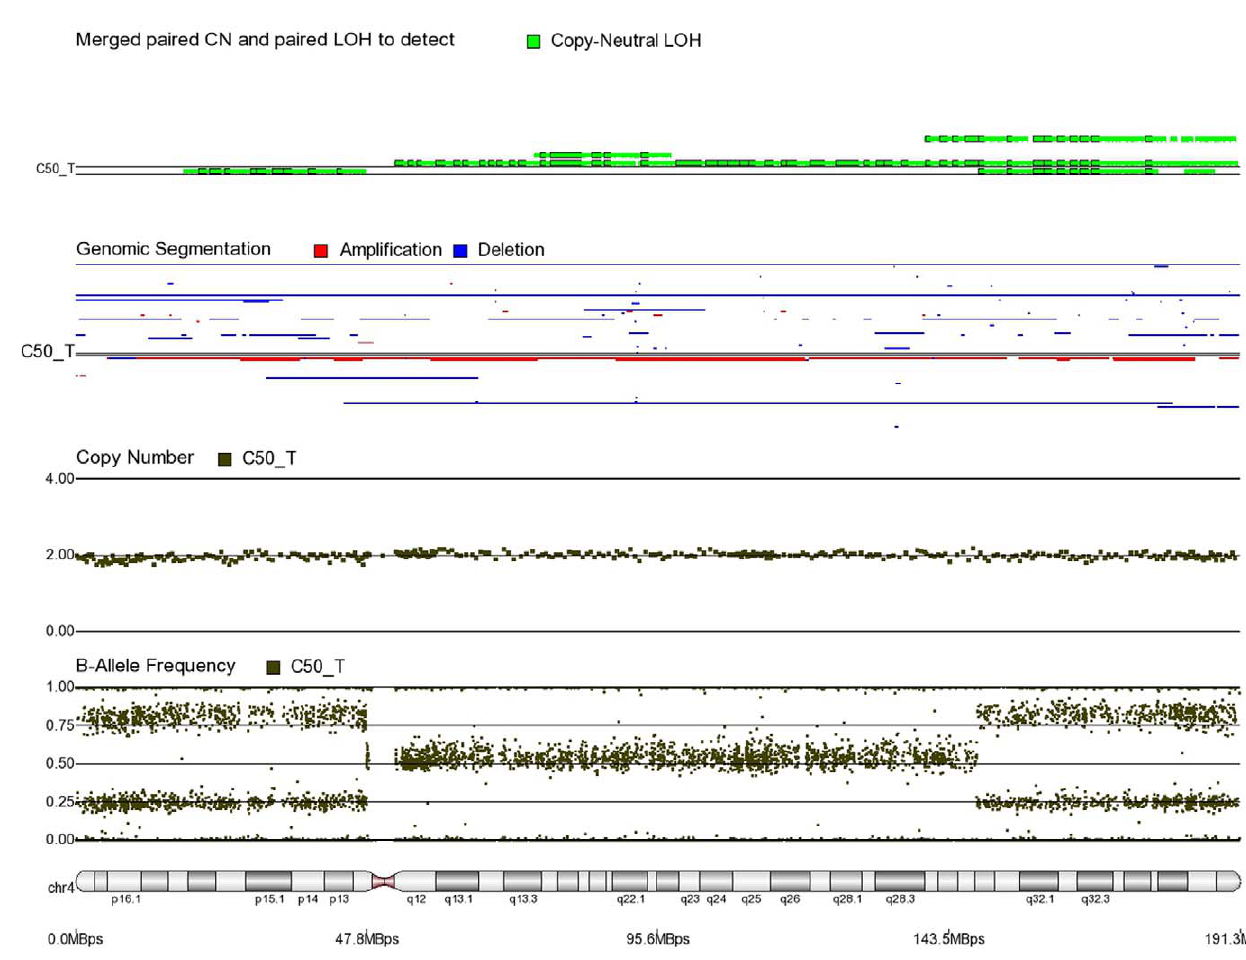
Figure 10. Mosaic cnLOH in chromosome 4 of CRC tissue sample C50_T. The cnLOH occurs in all of 4p and parts of 4q where BAF=0.25, 0.75 and CN=2. The portion of 4q where BAF=0.5 and CN=2 shows normal heterozygote patterns in all cells.